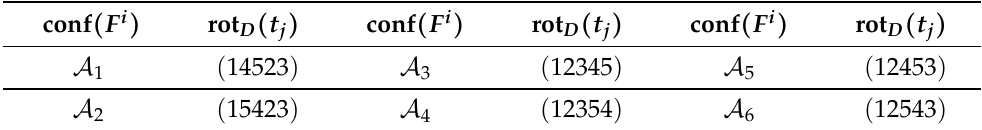
Table 2. The corresponding rotations of t j , for T i ∈ R D , F i = G ∗ ∪ T i and T j ∈ S D satisfying the restriction cr D ( T i , T j ) =